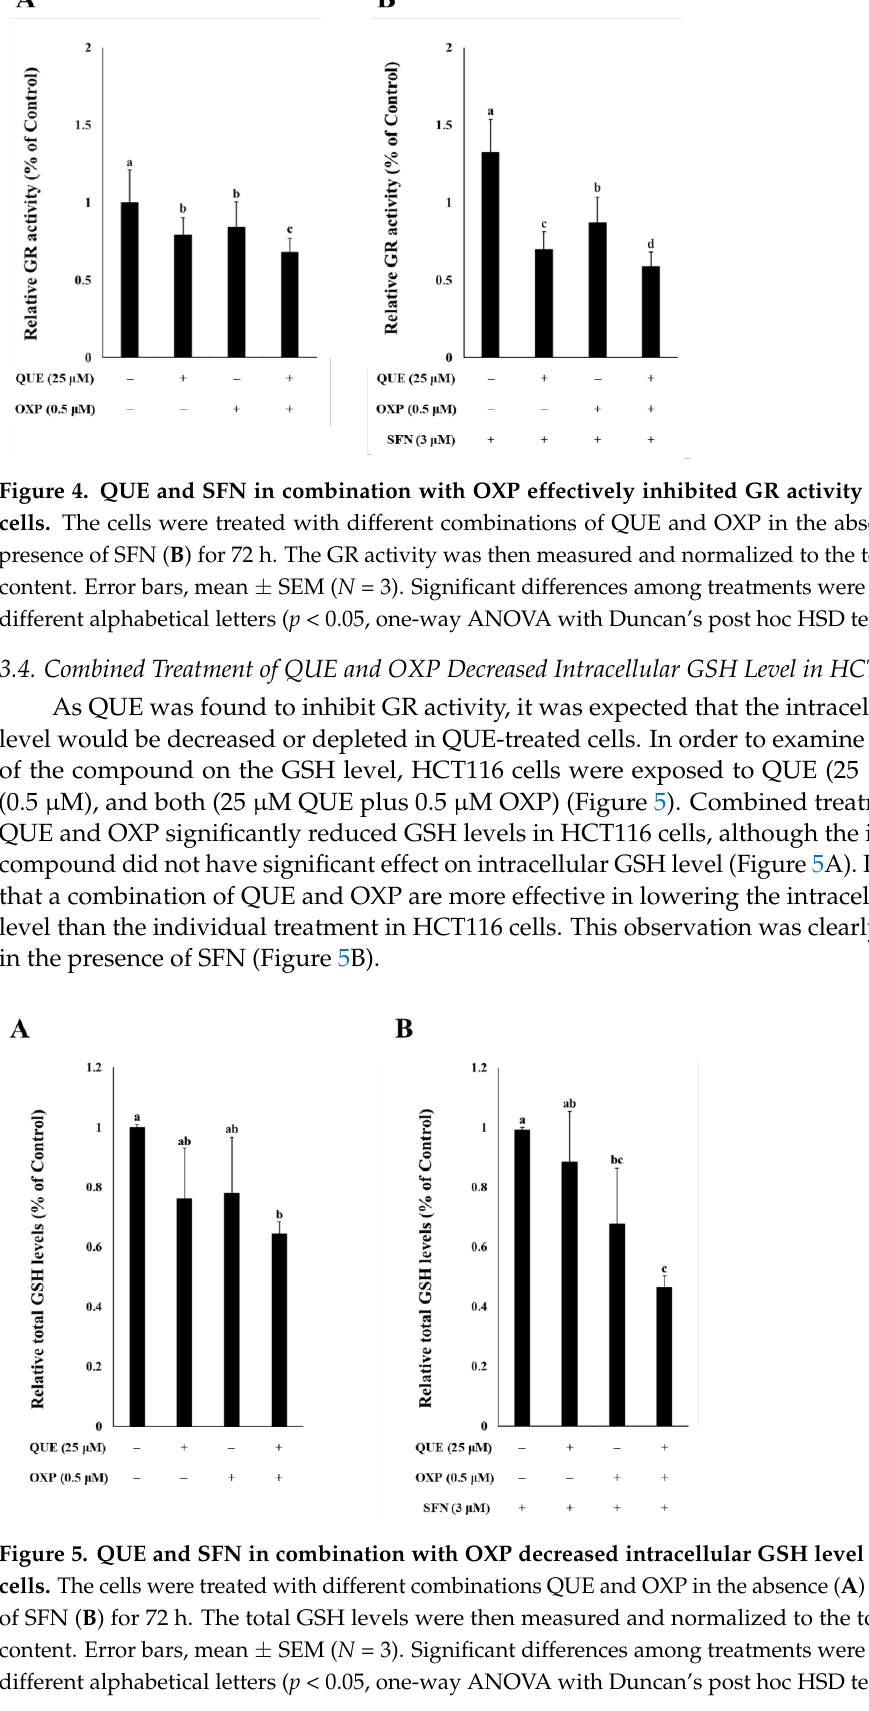
To assess the potential of a combined treatment with QUE and OXP for tumor sup- pression, we established HCT116 xenograft tumors in BALB/c nude mice. The tumor growth was accelerated by SFN treatment [22] . Consistent with our previous study, the average tumor volume was considerably increased when SFN alone was administered than that in the untreated control group (Figure 6). In addition, treatment with either QUE or OXP tended to suppress SFN-induced xenograft tumor growth (Figures 6 and 7). Figure 6. A combination of QUE, SFN, and OXP suppressed HCT116 xenograft tumor growth. QUE suppressed the tumor growth of HCT116 cells in vivo. The xenograft tumors were established by subcutaneously transplanting 3 × 10 6 HCT116 cells to BALB/c mice. The xenograft tumor-bearing mice were treated with QUE (50 mg/kg BW), OXP (10 mg/kg BW), SFN (5 mg/kg BW), and their